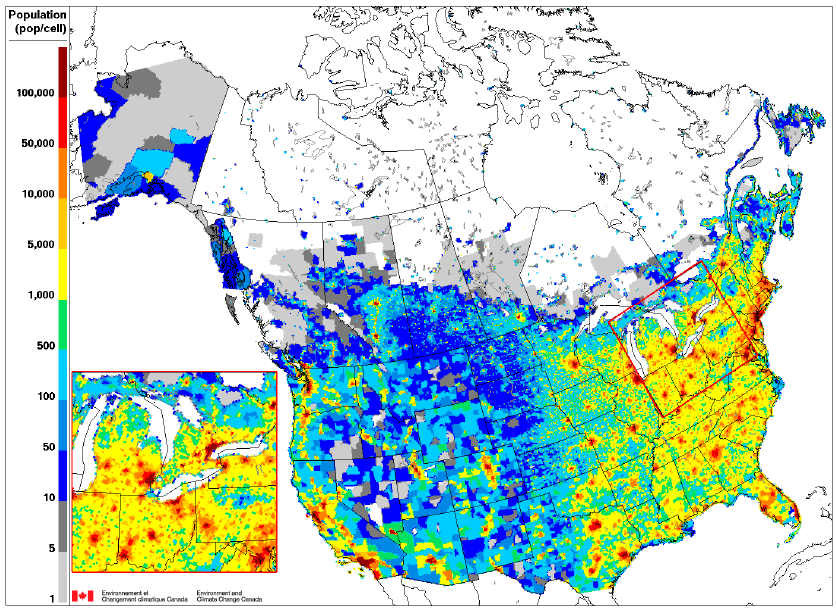
Figure 2. Population count per FireWork grid cell (10 km × 10 km) based on the 2016 Canadian census and the 2010 U.S. census. The red box over the four southern Great Lakes marks the location of the inset.